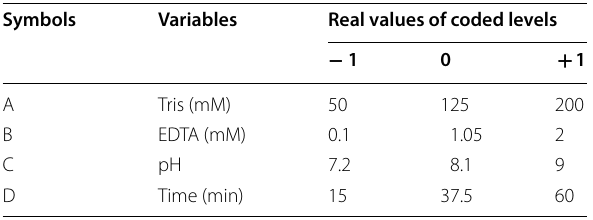
The central point (0) mentions middle values interval between the of each variable